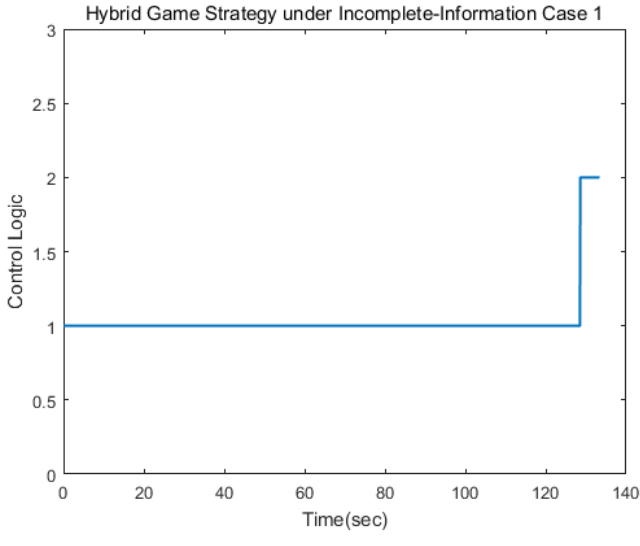
Figure 9. Control logic.